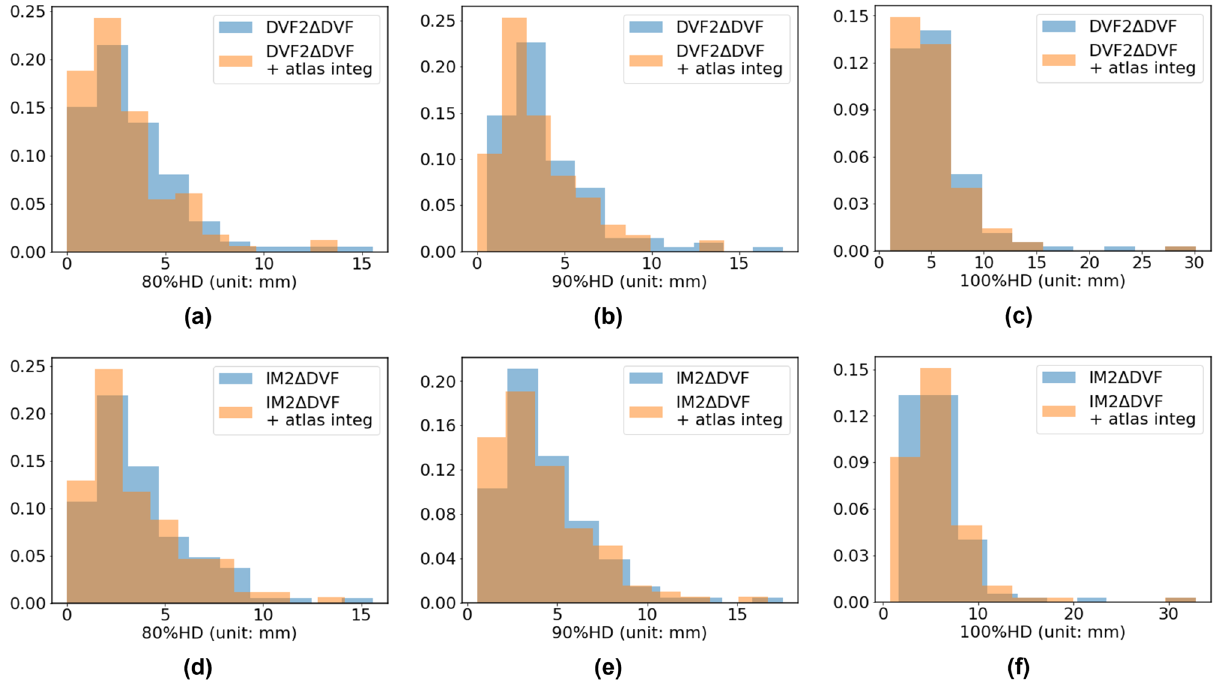
Figure 6. Vessel estimation accuracy when using a segmentation. The distribution of 80% HD, 90%HD, and 100% HD between the estimated vessel structure and the ground truth vessel structure before and after the DVF2∆DVF ( a - c ) or IM2∆DVF ( d - f ) refinement network. The distribution of 80% HD values for using no refinement network, using DVF2∆DVF, using DVF2∆DVF + atlas integration, using IM2∆DVF, and using IM2∆DVF + atlas integration are 2.92 ± 2.68, 3.33 ± 2.60, 3.67 ± 2.55, 289 ± 2.30, 3.50 ± 2.54, respectively. The distribution of 90% HD evaluated for these methods are 3.51 ± 2.87, 3.94 ± 2.76, 4.30 ± 2.69, 3.48 ± 2.40, and 4.14 ± 2.75, respectively. And the distribution of 100% HD evaluated for these methods are 5.12 ± 3.82, 5.54 ± 3.73, 5.98 ± 3.80, 5.10 ± 3.38, 5.83 ± 3.84, respectively.